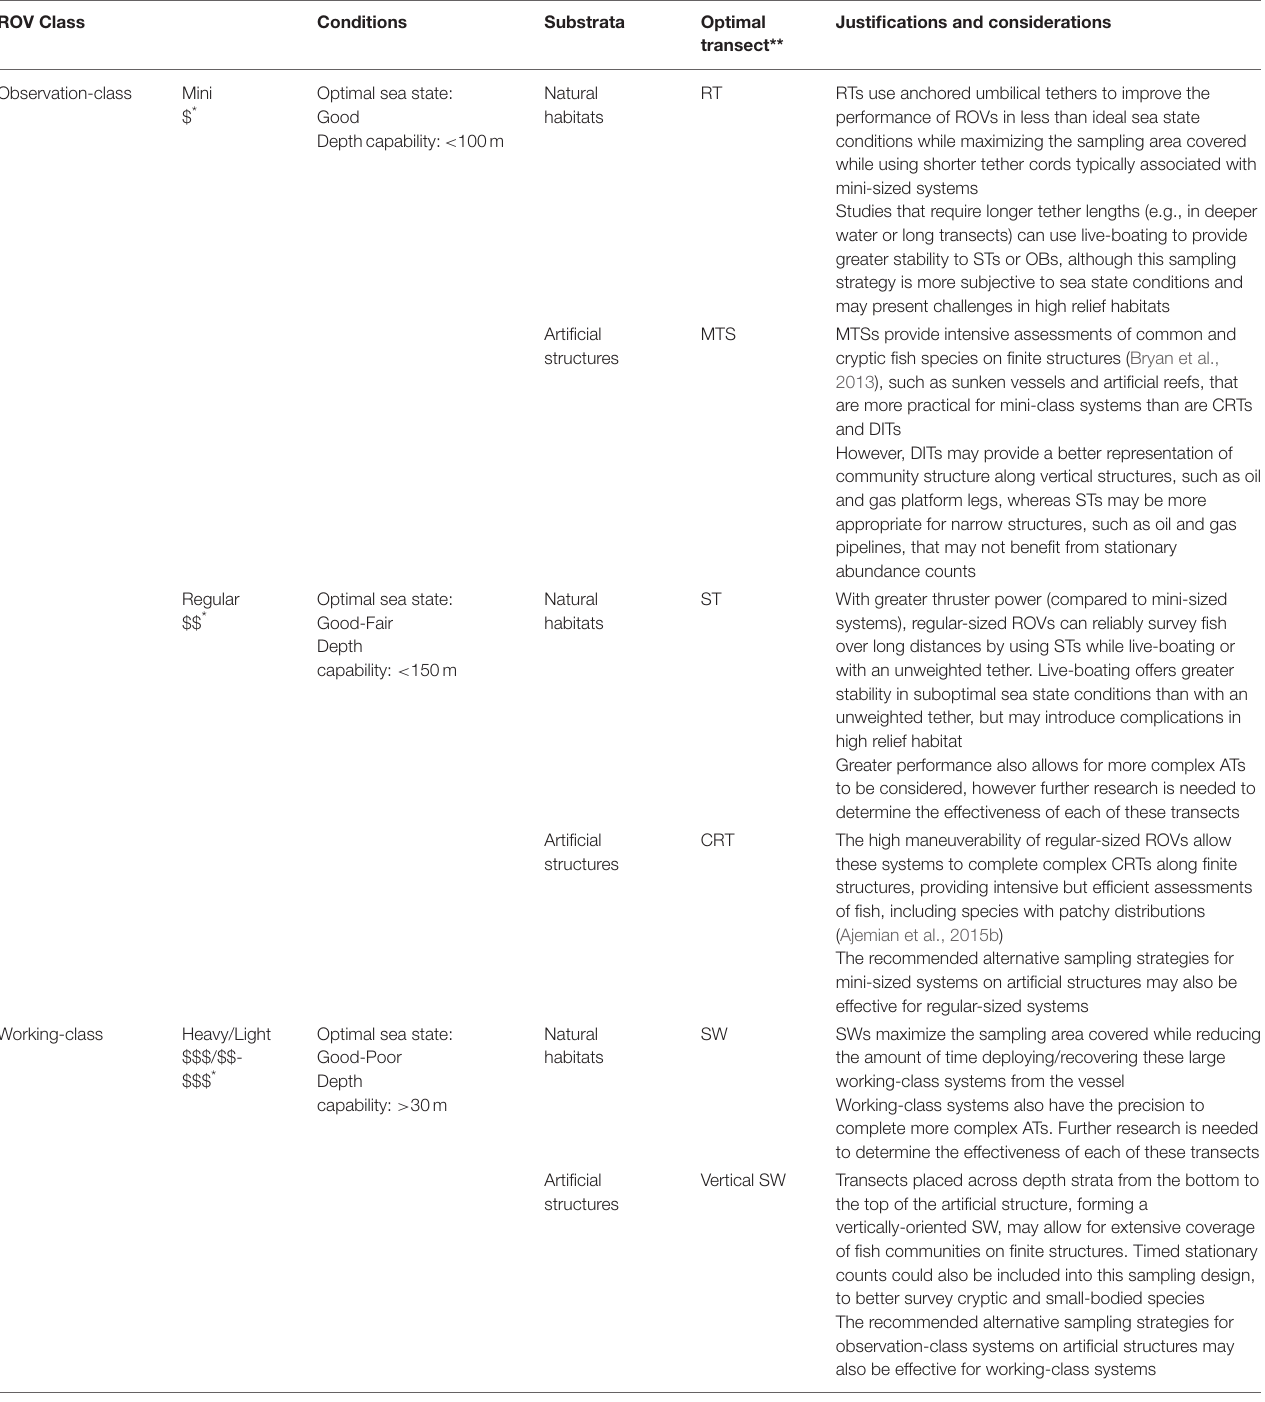
TABLE 5 | Surveying strategies recommended for each ROV class in different types of studies and environmental